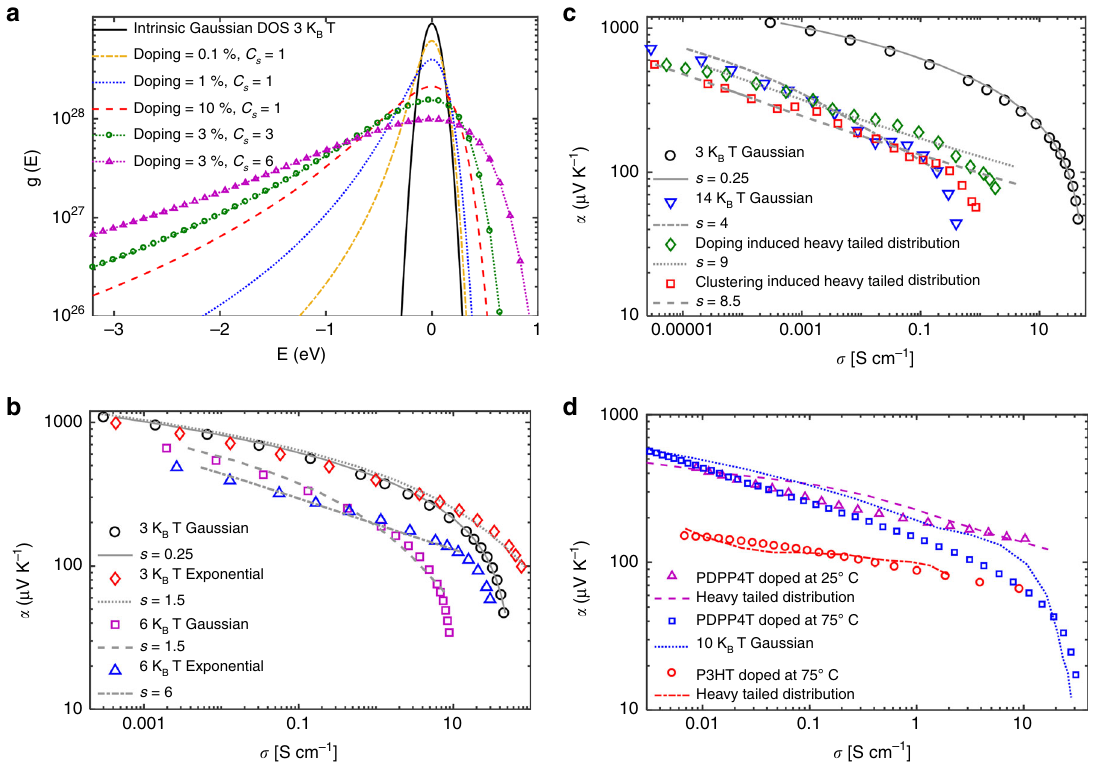
Fig. 6 Simulated dopant-induced Seebeck and conductivity trends. a The effect of doping and clustering on the density of states (DOS) distribution with intrinsic Gaussian width of 3 k B T . The charge carriers interact coulombically with the ionized dopants creating additional deep trap states, resulting in a heavy-tailed DOS. Log-log plot of Seebeck coef fi cient vs. conductivity showing the change in slope due to: b Gaussian and exponential DOS, c Doping and clustering induced heavy-tailed DOS. The doping-induced distribution is computed with dopant concentration N d = 10% and cluster concentration C s = 1, and the clustering induced distribution with N d = 3% and C s = 3. We have fi t our simulated results (symbols) to Snyder and Kang ’ s charge transport model (gray lines) and the corresponding transport parameter ‘ s ’ values are shown. d Comparison of our model to experimental data from Fig. 3. ( N d = 4% and C = 1 for pink dashed line, N = 0.9% and C = 9 for red dot-dashed line, γ = 0.01 and ∑ = 0.0025 for all three cases) s d s ij